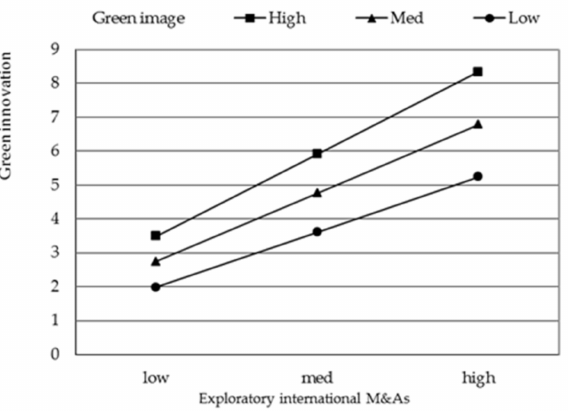
Figure 2. Moderating effect of green image on the relationship between exploratory international M&A and green innovation